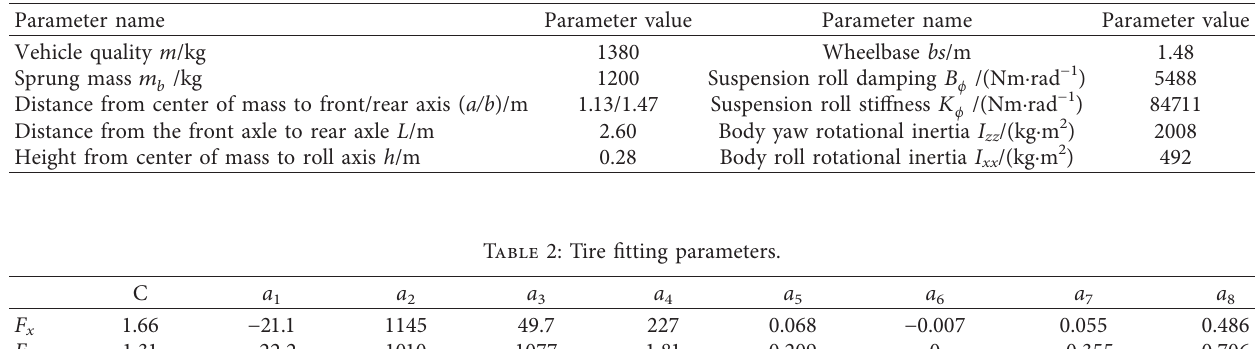
Table 1: Vehicle parameters.